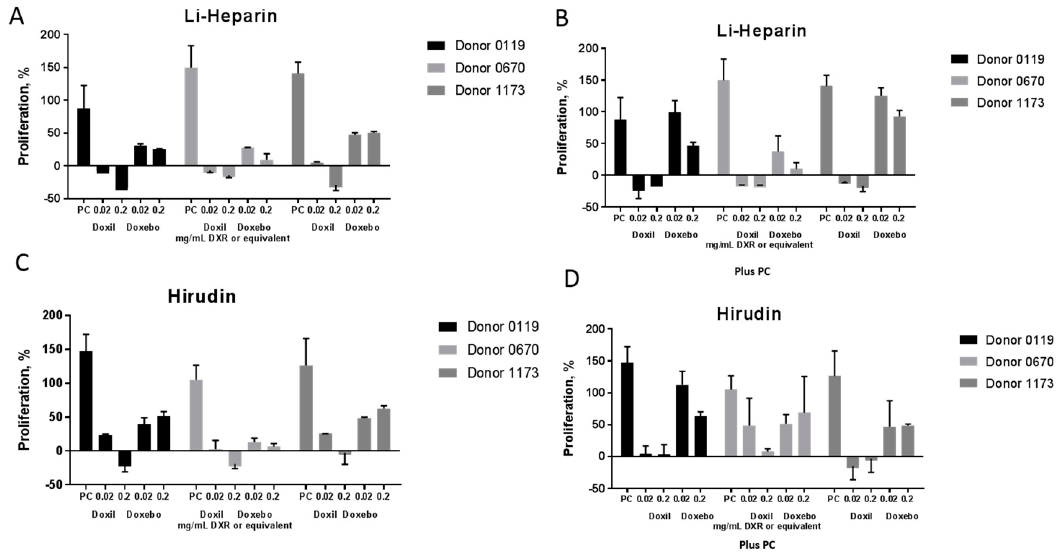
Figure 6. Leukocyte Proliferation PBMC from three healthy donor volunteers was cultured in